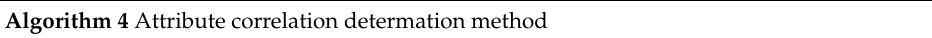
Algorithm 4 for finding non-sensitive attributes linked to sensitive attributes is